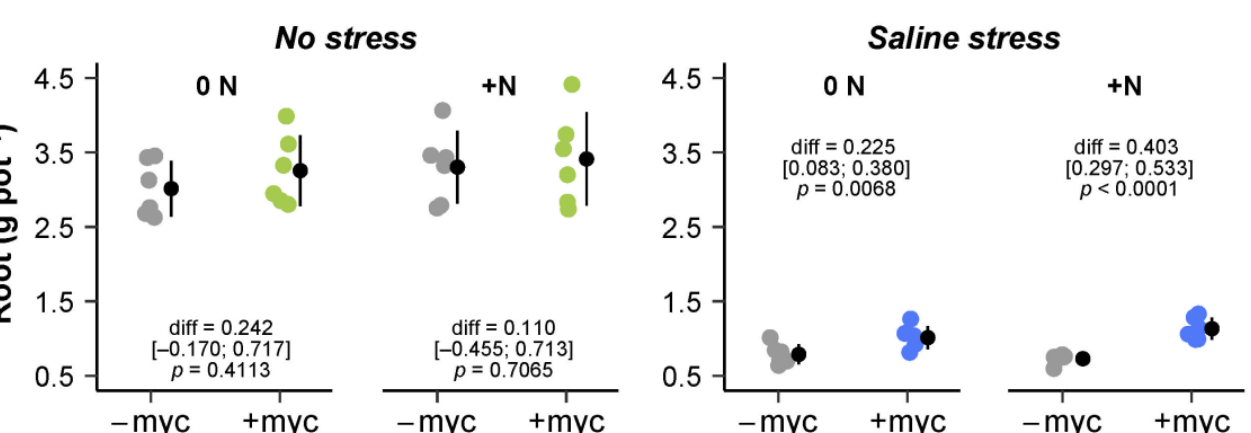
Figure 4. N concentration (g N kg −1 of dry weight) of durum wheat total biomass to varying treat- ments: no-stress or saline stress condition; N fertilization treatments (0 N, +N); absence or presence of arbuscular mycorrhizal fungal inoculum ( − myc, +myc). Black circles represent means, with whiskers representing ± SE ( n = 6). Differences (diff) between +myc and − myc means within the same fertilization treatment and the same saline treatment, estimated 95% confidence intervals of mean difference (in brackets), and p values are reported inside the plots.